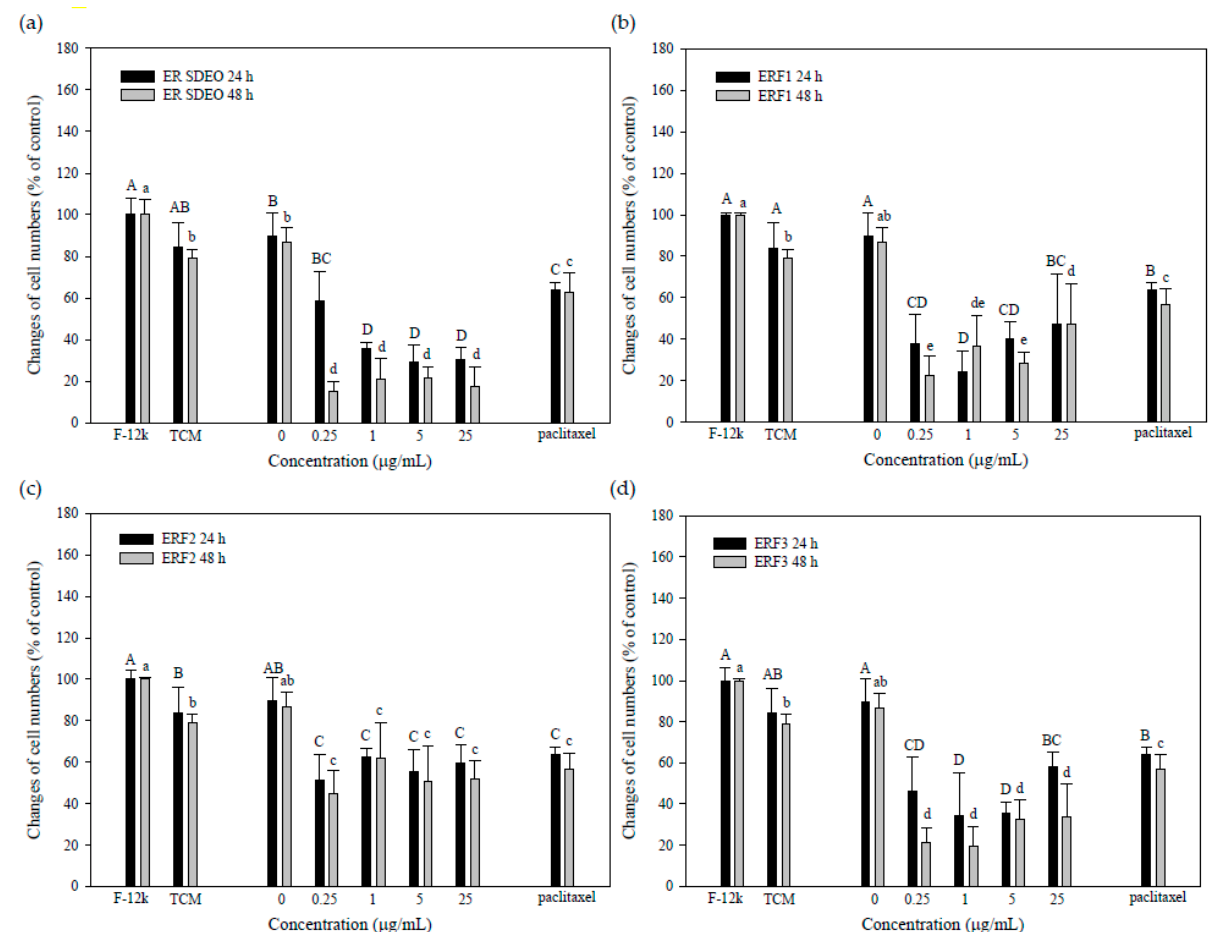
Figure 5. Effects of SCM prepared in the absence or presence ER SDEO ( a ), ERF1 ( b ), ERF2 ( c ), and ERF3 ( d ) on PC-3 cell growth. Cells (1 × 10 6 cells/mL) were treated with SCM for 24 and 48 h, respectively. Values are means ± SD ( n = 4 biological determinations). Bars in the same plot at the same incubation time not sharing a common letter are significantly different ( p < 0.05) from each other assayed by one-way ANOVA, followed by DuncaN (cid:48) s multiple range test. SCM, splenocyte-conditioned medium. PC, positive control (paclitaxel at 2.5 µ